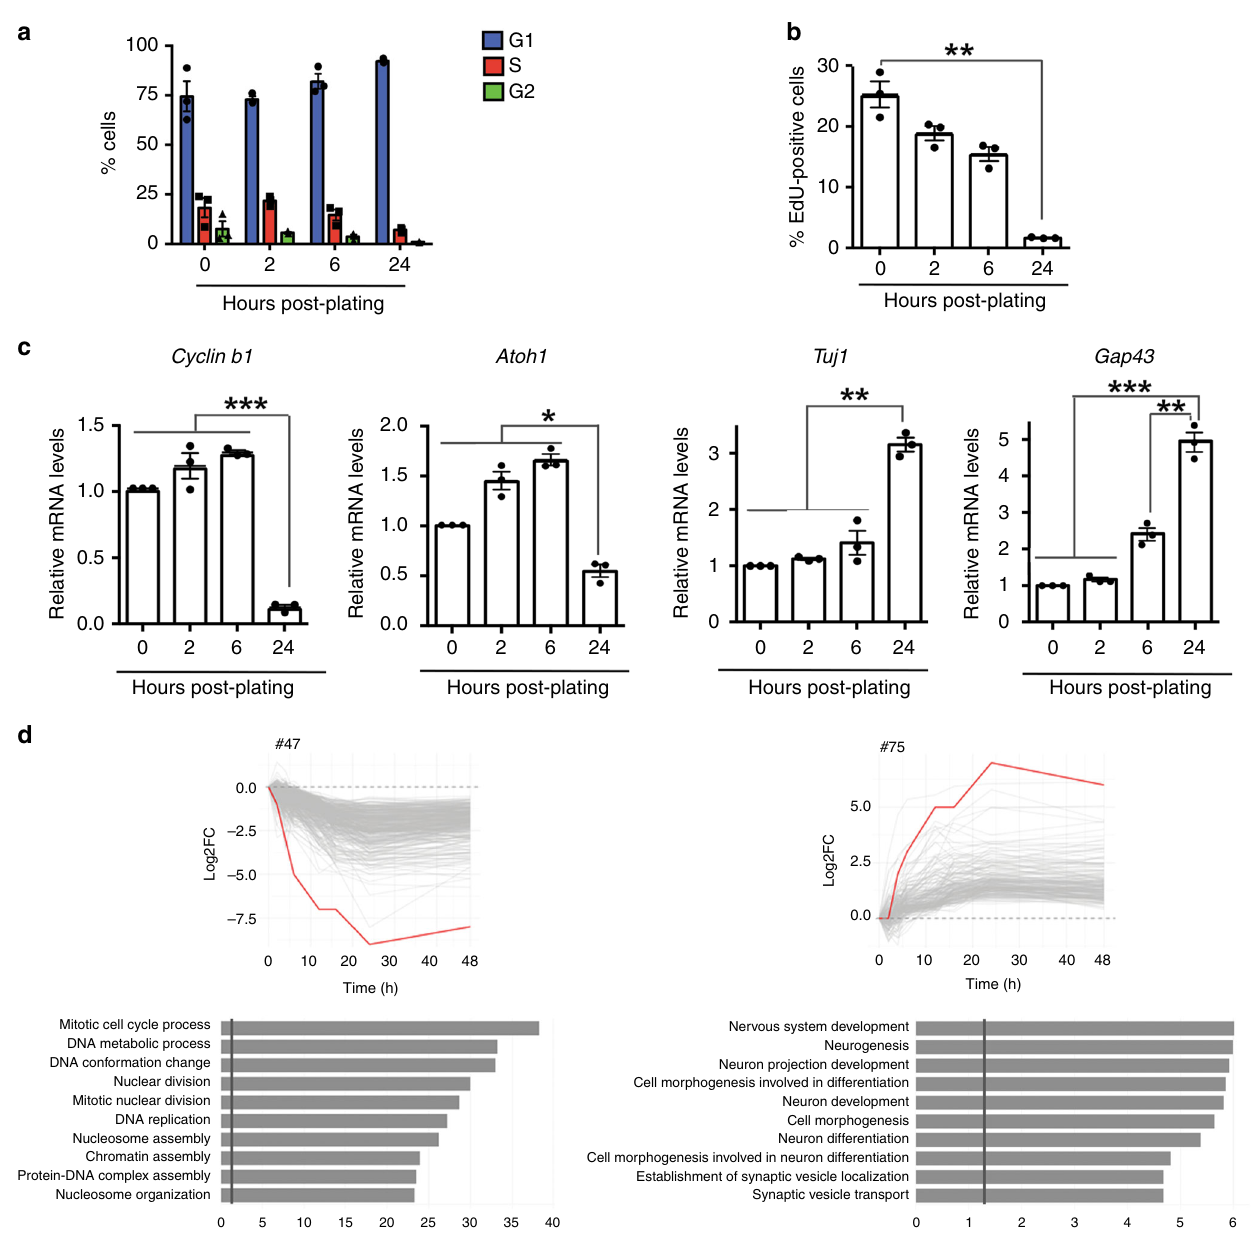
Fig. 1 Timing of cycle exit in GCPs. a GCPs exit the cell cycle within 24h of plating as judged by PI-FACS analysis. FACS analysis was performed on GCPs puri fi ed from P6 mice and plated for the time intervals indicated. FlowJo software was then used to assess the percentage of cells in the G1, S, or G2/M phase. b Puri fi ed GCPs exit the cell cycle within 24 h of plating as judged by EdU incorporation studies. GCPs puri fi ed from P6 mice were processed for EdU incorporation, which was normalized to the total number of cells labeled with Hoechst staining. c Puri fi ed GCPs from P6 mice were plated and processed for the RNA expression at the time intervals indicated for the proliferative markers, Ccnb1 and Atoh1 , and the differentiation markers, Tuj1 and Gap43 . qRT- PCR was performed and normalized to Gapdh . d Short-time series modeling of mRNAs during cell-cycle exit. Plots represent mRNA expression pro fi les during GCP cell-cycle exit. Representative clusters (#47, #75 and their related cellular processes) are shown. The red line represents the consensus for each cluster. The gray lines represent individual mRNA expression pro fi les. The associated biological processes as de fi ned by DAVID 41 in each cluster are shown. The identity of each gene in the cluster can be found in Supplementary Data 1. The results are shown as the average values of three independent experiments and are represented as the mean ± SEM. A one-way ANOVA followed by Bonferroni multiple comparison testing was performed (* p < 0.05, ** p < 0.01). Source data can be found in source data graphs under tabs for a – c